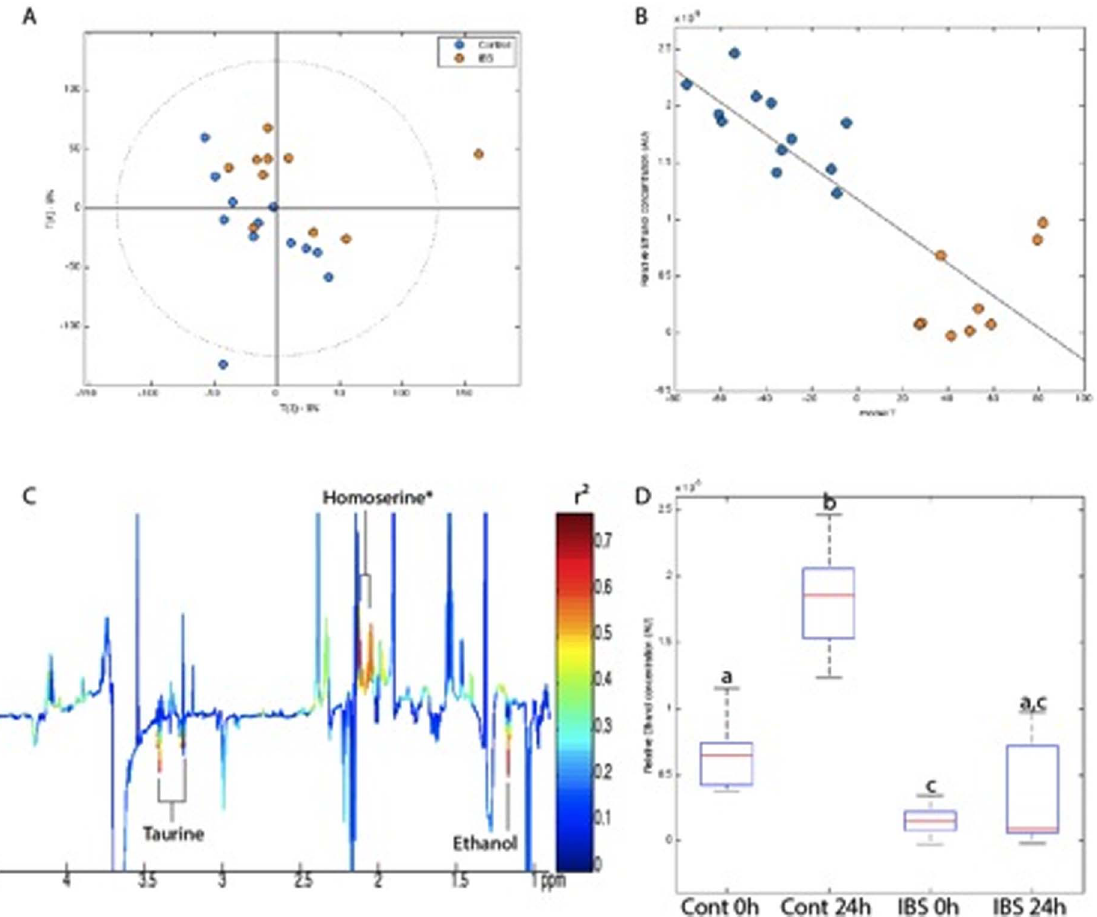
Figure 2. Divergent fermentation of bread samples by IBS and control microbiota. PCA scores plot (A) and O-PLS-DA scores (B) and associated loadings (C) derived from 700 MHz 1 H NMR spectra of fermentation supernatants. Relative ethanol production derived from the integrated area under the curve of original NMR spectra for the methyl protons at 1.18 ppm. ANOVA: p , 2.10 2 16 ; Multiple comparison test: (a) p , 0.0001 different from b and c, (b) p , 0.0001 different from a and c. Key: Blue: control; Orange: IBS. *putative assignement.